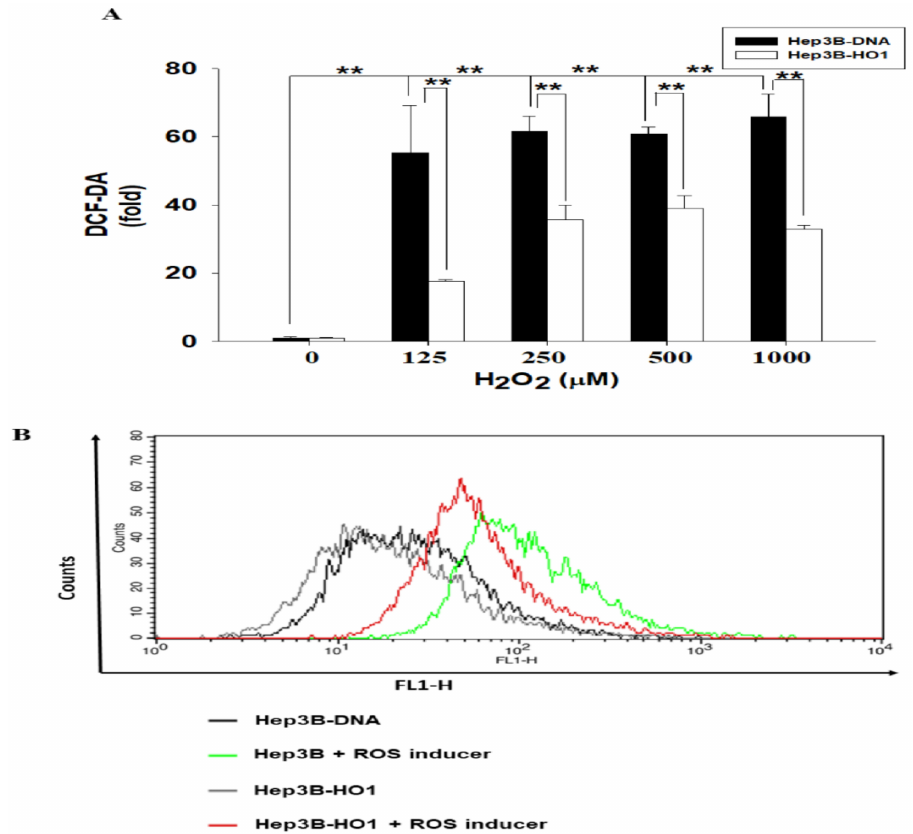
Figure 2. HO-1 alleviates ROS generation in human hepatoma cells. ( A ) Fold change of ROS generation through various concentrations of H 2 O 2 stimulation for 1 h on Hep3B–DNA and Hep3B-HO1 cells detected by DCF-DA dye. ( B ) The flow cytometry determined that overexpression of HO-1 blocked ROS generation stimulated by 20 µ M of pyocyanin. (**, p <